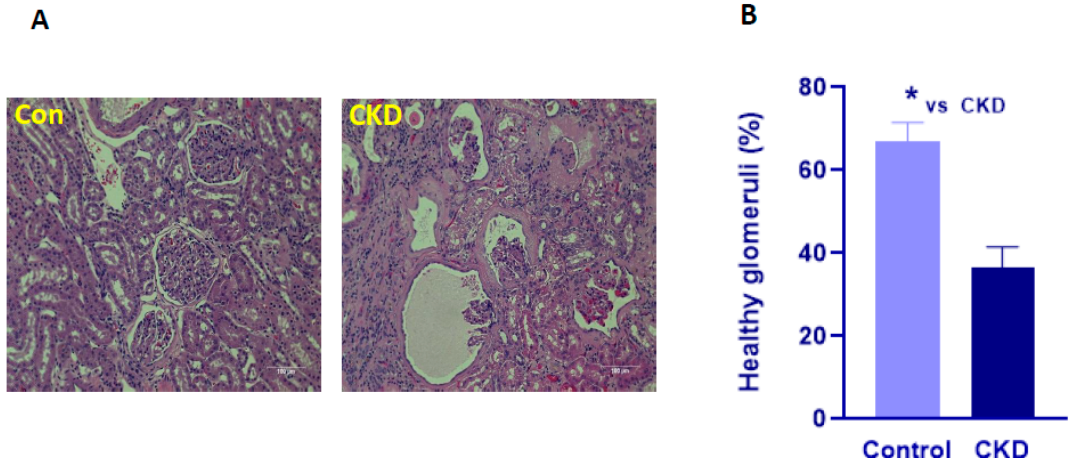
Figure 2. Photomicrographs of canine H&E- stained renal sections. ( A ) Representative photomi- crographs of H&E-stained renal sections in Control (Con) and chronic kidney disease (CKD). Scale bar = 100 micron. ( B ) Quantification of healthy glomeruli per field in control ( n = 10) and CKD dogs ( n = 10). The number of healthy glomeruli was assessed in 29–34 fields in each slide for each dog (see text for details). Data are presented as Mean ± SEM (* p < 0.05).